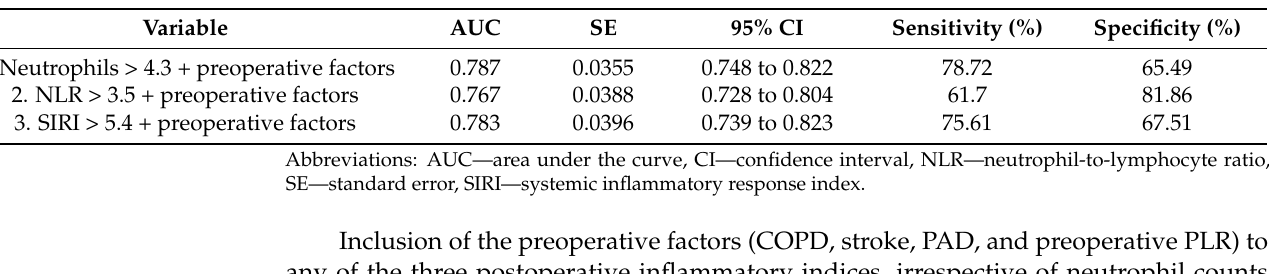
( C ) Figure 3. Receiver operator characteristics curves of three hematologic indices related to neutrophils